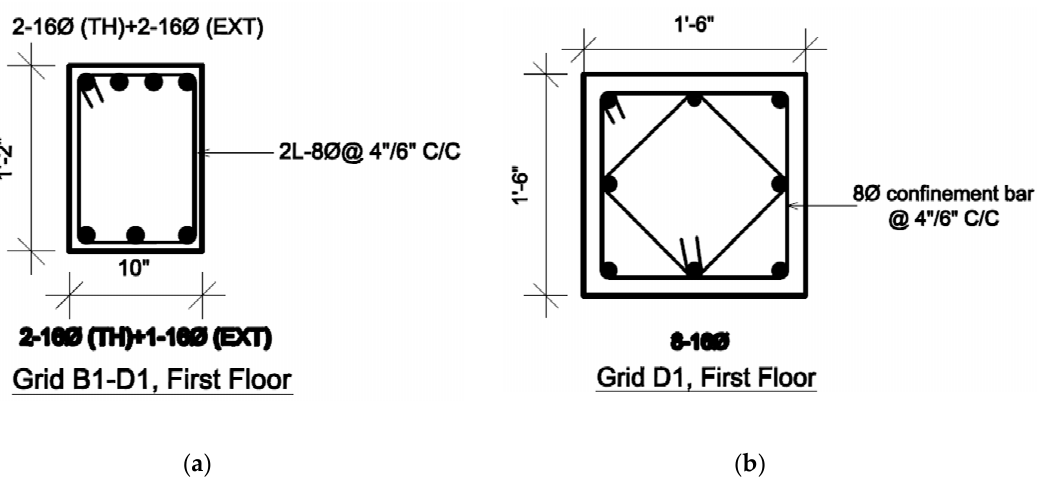
Figure 3. Details of structural members: ( a ) Typical beam; ( b ) Typical column.